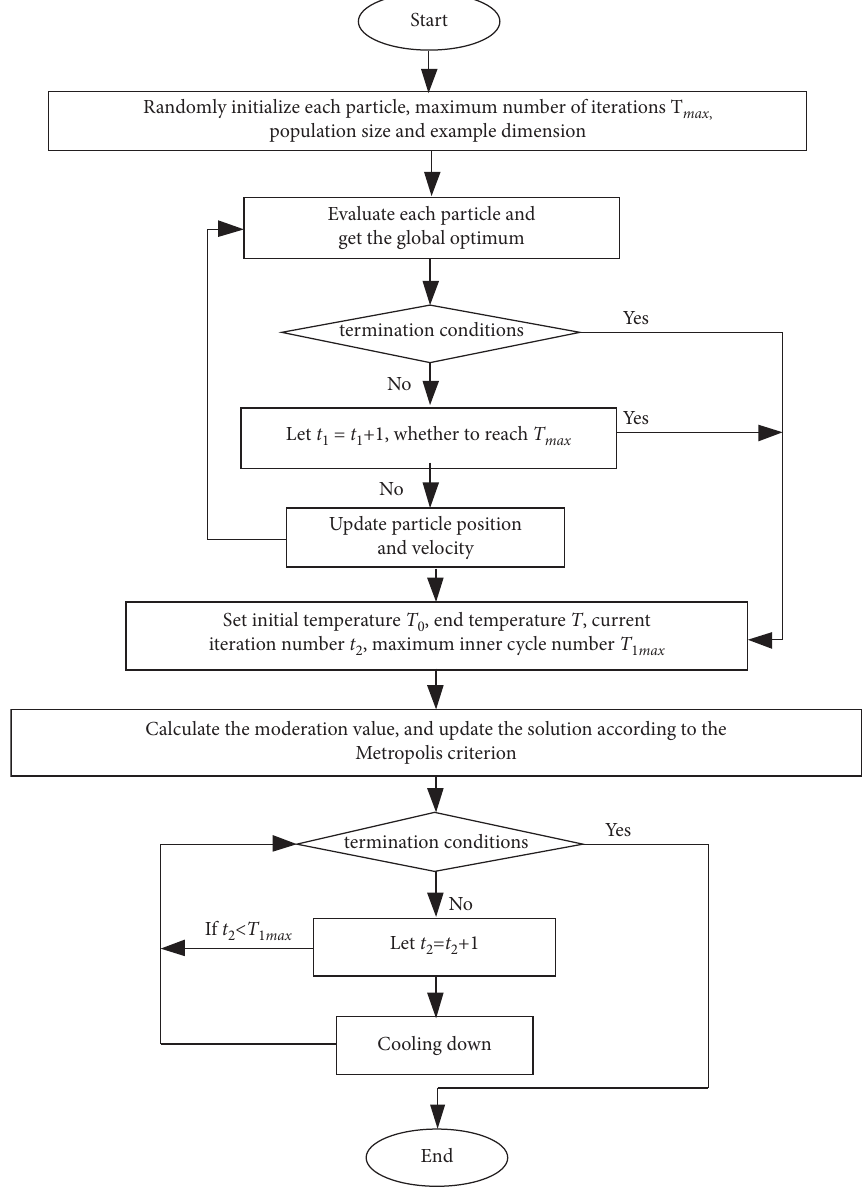
Figure 2: Amplitude curves of each degree detected based on PSO-SA